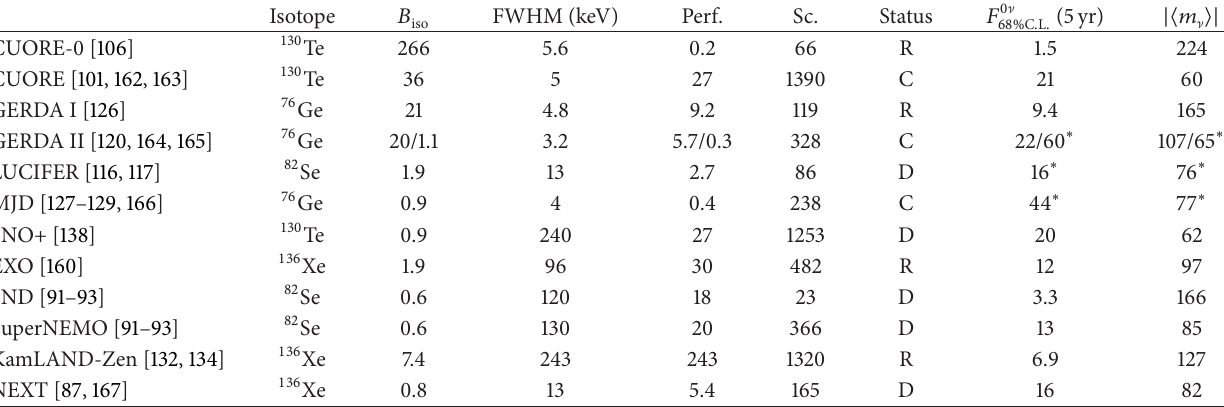
Table 15: List of sensitivity parameters for some of the most advanced 𝛽𝛽(0 ] ) projects. 𝐵 is the background per tonne of isotope mass in iso units of counts/(keV ⋅ tonne ⋅ yr). The column labeled “Perf.” reports the performance index (11) in units of 10 − 3 counts/( 𝑛 𝛽𝛽 ⋅ yr). The column labeled “Sc.” reports the scale of the experiment (11) in units of 𝑛 𝛽𝛽 (number of effective moles of isotope × yr). The status of the experiment, R (running), C (construction), and D (development), is shown in the column labelled “Status.” Sensitivities (in unit 10 25 yr) are evaluated according to (9) and (10) as appropriate, assuming 5 years of running time. |⟨𝑚 ] ⟩| values (meV) are calculated using NME and phase space factors from [38, 44], respectively. Asterisks label ZB conditions; in the case of GERDA II we report two different sensitivities according to the two hypotheses discussed in Section